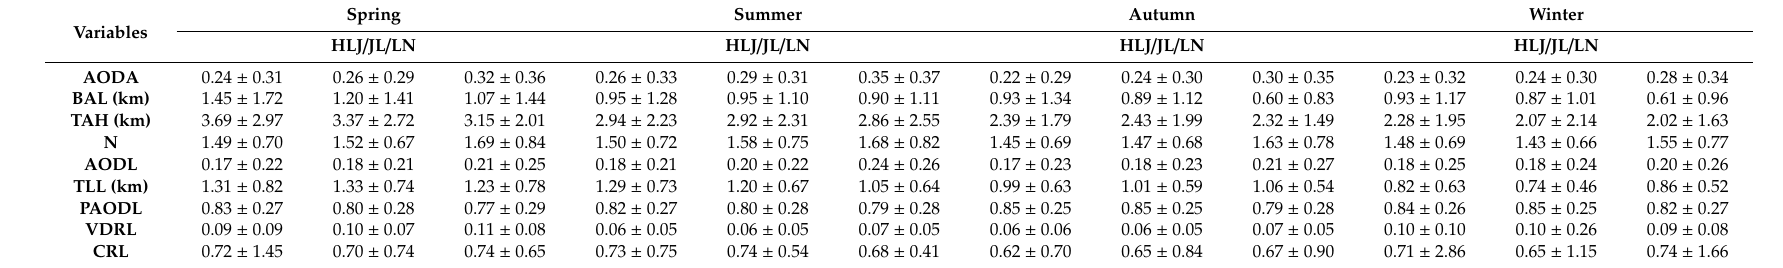
Table 1. Seasonal mean and standard deviation values of nine variables in the daytime over NEC (HLJ, JL, and LN).